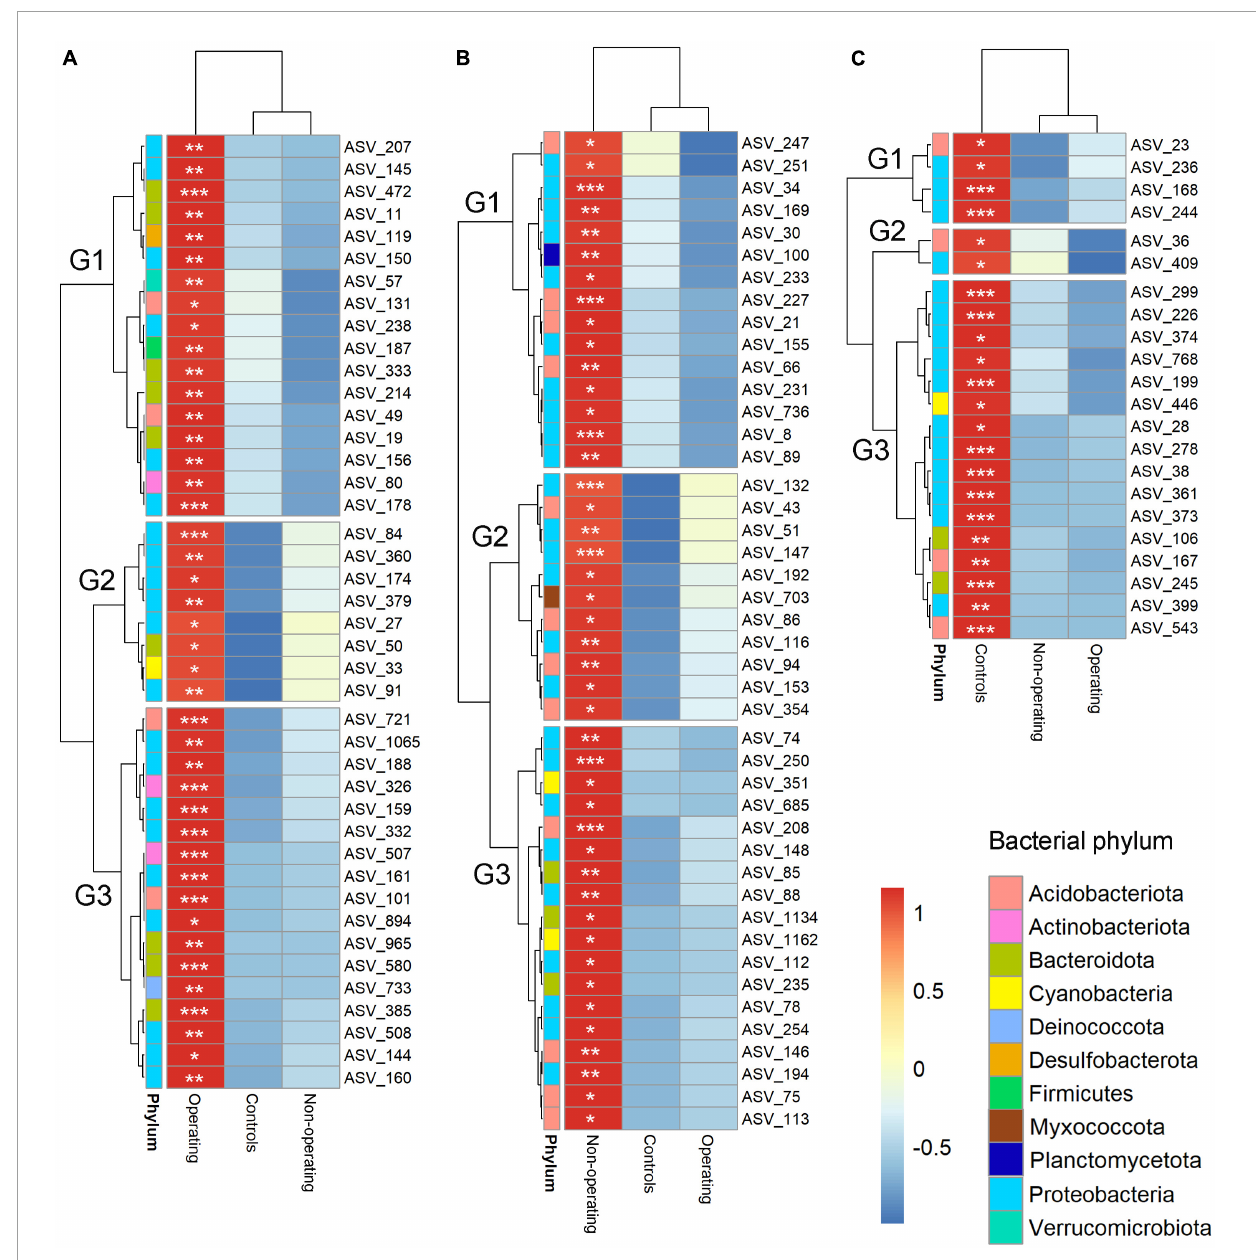
FIGURE4 Hierarchical clustering heatmaps of the relative abundance (scale by row) of bacterial indicator ASVs for mining stages. (A) Indicators for operating mines; (B) indicators for non-operating sites; and (C) indicators for control sites. The color-coded scale indicates an increase (red) and a decrease (blue). Only ASVs with total relative abundance > 0.05% were included in the indicator analysis. * P < 0.05; ** P < 0.01; *** P < 0.001. Note relative abundance of each bacterial and fungal ASV is shown for each mine stage when not an indicator ASV in that